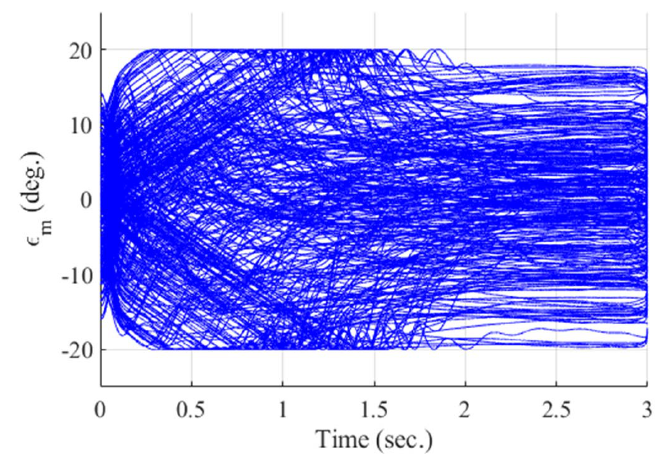
Figure 15. Look angle of the missile (Monte Carlo simulation).